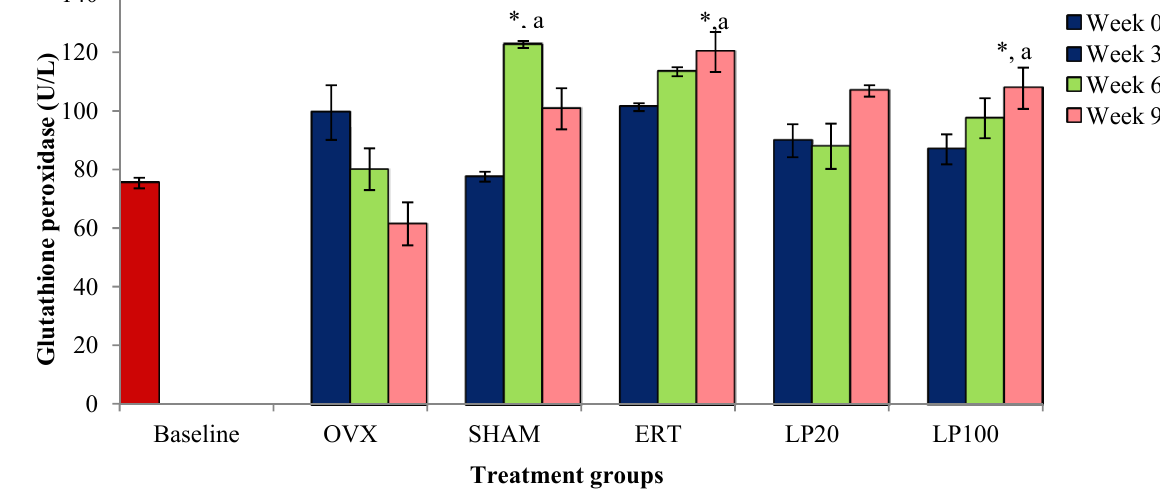
Figure 2. Mean glutathione peroxidase concentration for all the groups after 3, 6 and 9 weeks of treatment. Data presented mean ± SEM ( p < 0.05). SHAM: sham-operated, OVX: ovariectomized control, ERT: ovariectomized and estrogen supplementation, LP20: ovariectomized and supplemented with LP at the dose of 20 mg/kg, LP100: ovariectomized and supplemented with LP at the dose of 100 mg/kg. * p < 0.05 versus Baseline; a p < 0.05 versus OVX at the corresponding